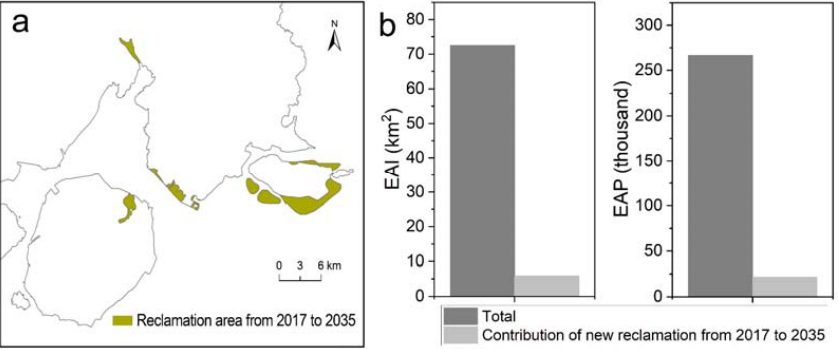
Figure 9. ( a ) New reclamation area from 2017 to 2035; and ( b ) expected annual inundation (EAI) and expected annual population (EAP) exposed to coastal flooding in 2035, under the scenario considering future reclamation.